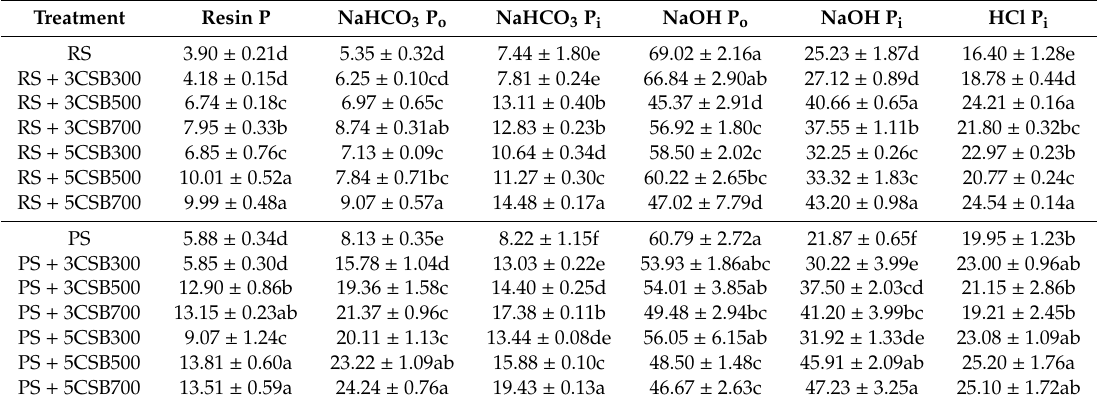
Table 3. Phosphorus fractionations of two soil types after incubation of di ff erent pyrolysis temperature CSB application (mg · kg − 1